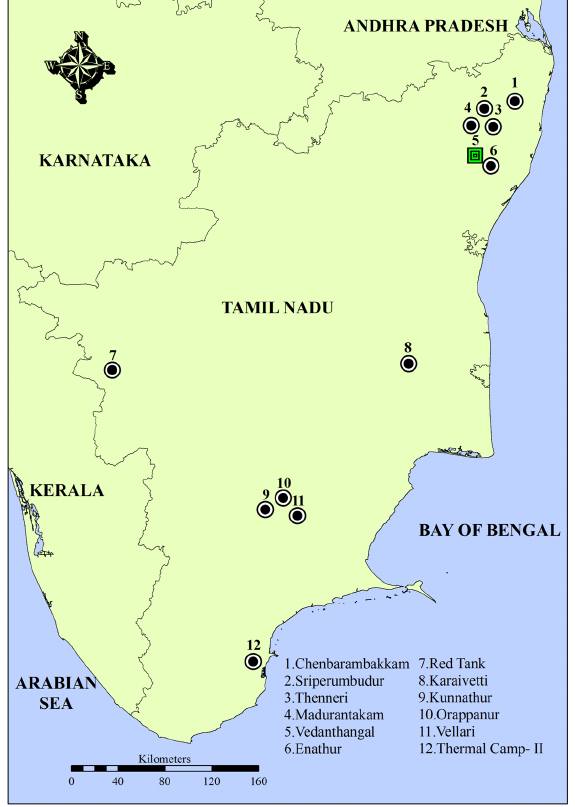
Figure 1. Map showing the distribution of Common Pochard in Tamil Nadu.